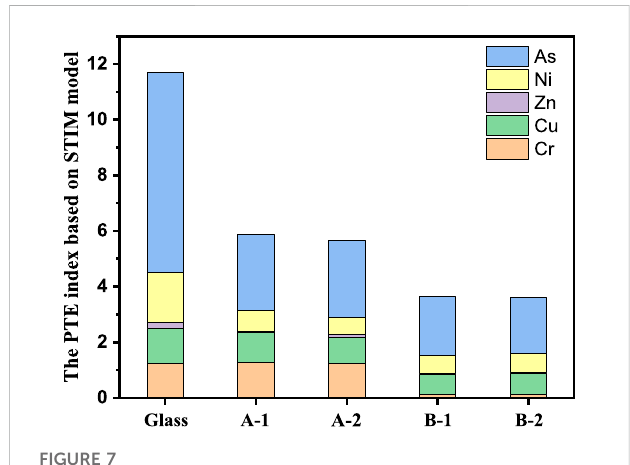
FIGURE 7 PTEs index of heavy metals. A-1: sintered at 850 ° C for 1 h, A-1: sintered at 850 ° C for 2 h, B-1: sintered at 1,050 ° C for 1 h, B-2 is sintered at 1,050 ° C for 2